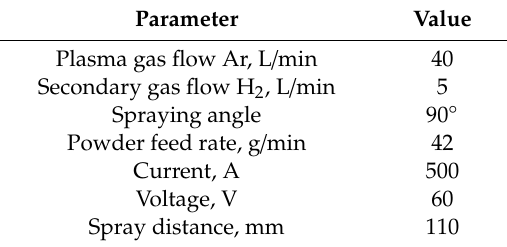
Table 1. Spraying